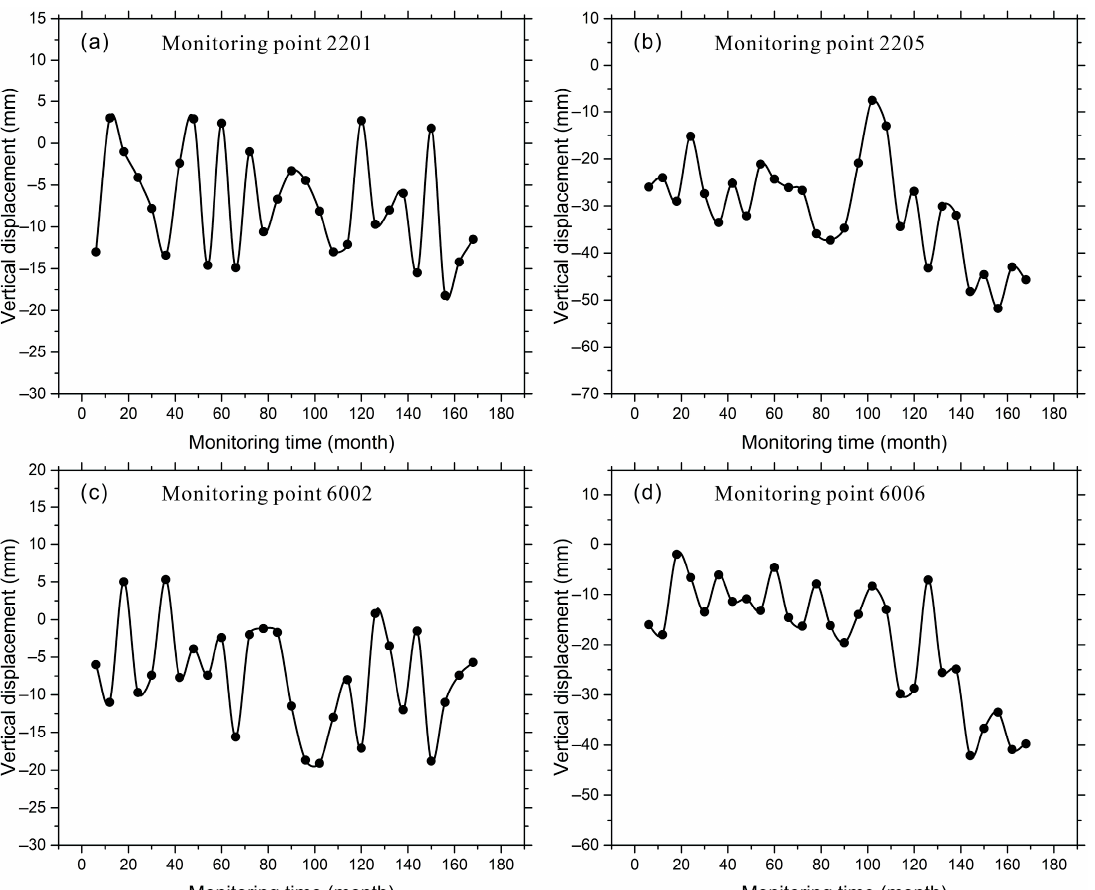
Figure 3. Mine subsidence time series of several monitoring points at the Jinchuan Nickel Mine: ( a ) monitoring point 2201, ( b ) monitoring point 2205, ( c ) monitoring point 6002, ( d ) monitoring point 6006.